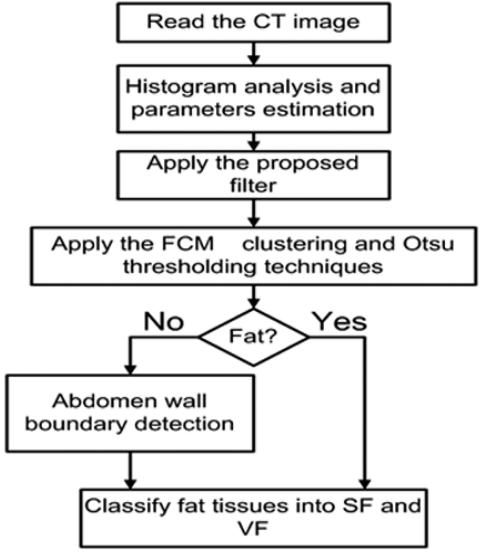
Figure 8. Structure of the abdomen fat segmentation method.